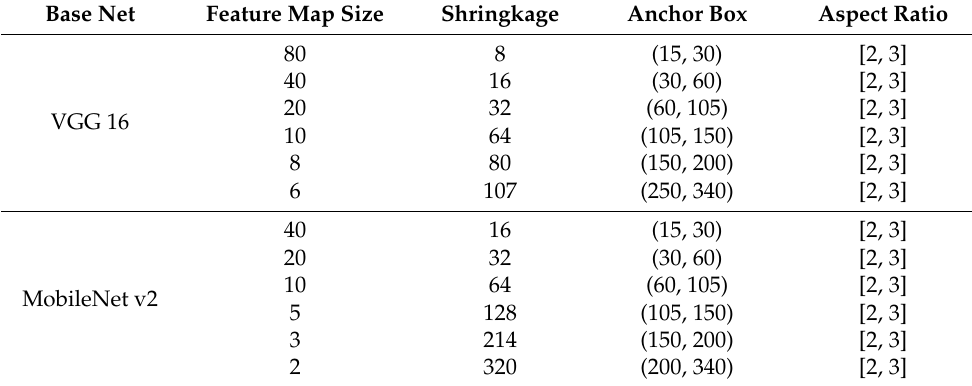
Table 5. Setting of the SSD anchor